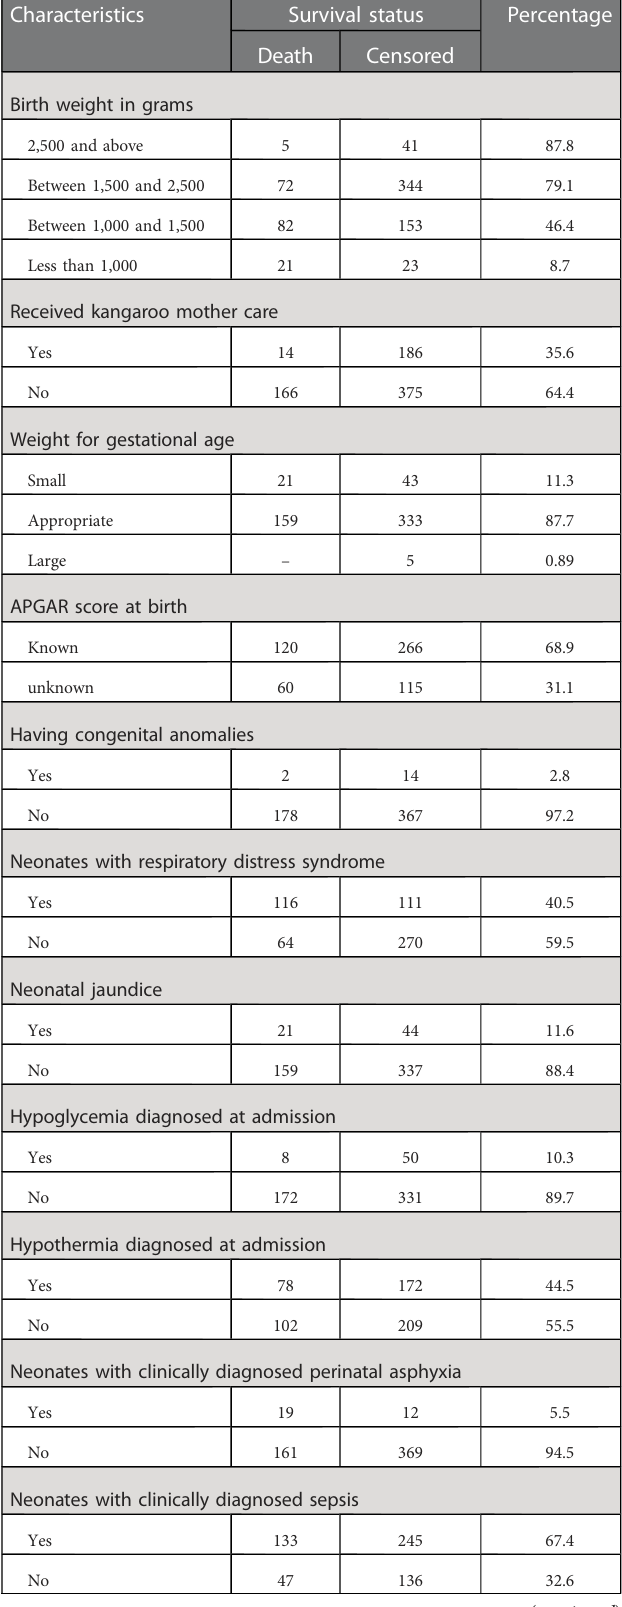
TABLE 2 Distribution of neonatal-related characteristics for preterm neonates in Northern Ethiopia, 2022 ( n =561).